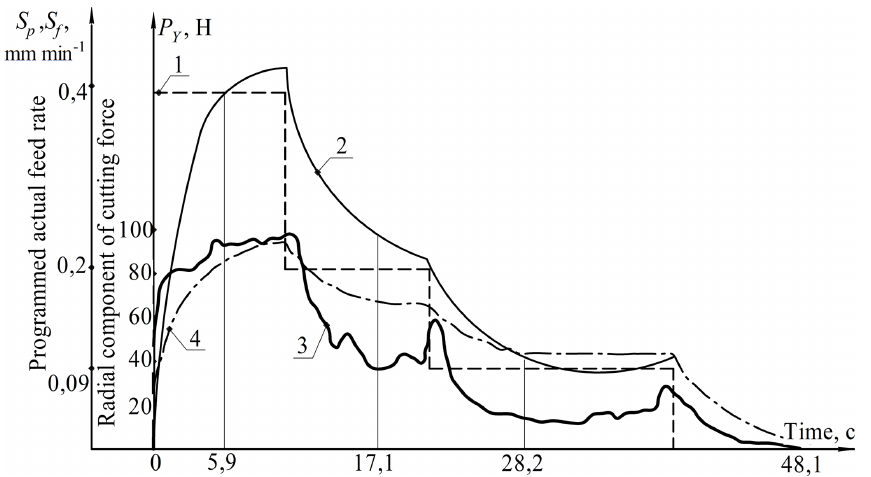
Figure 6. Graphs of complex experiment No. 1: (1) experimental graph of the change in the program feed rate in time; (2) experimental graph of the change in the actual speed of delivery in time; (3) experimental graph of the variation of the radial cutting force in time; (4) theoretical graph of the change in the radial component of the cutting force in